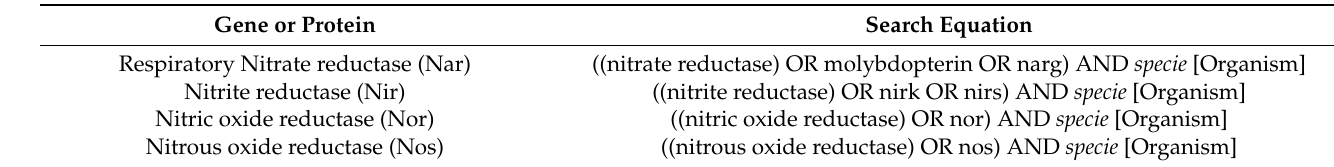
Table 1. Search equations employed in this work.